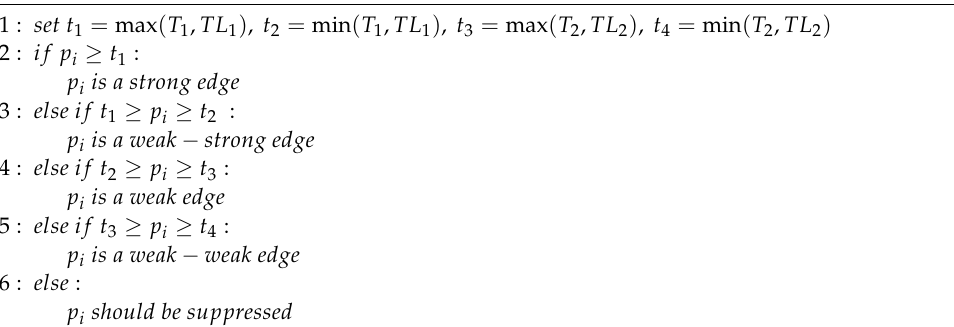
Algorithm 2 Improved double adaptive dual-threshold